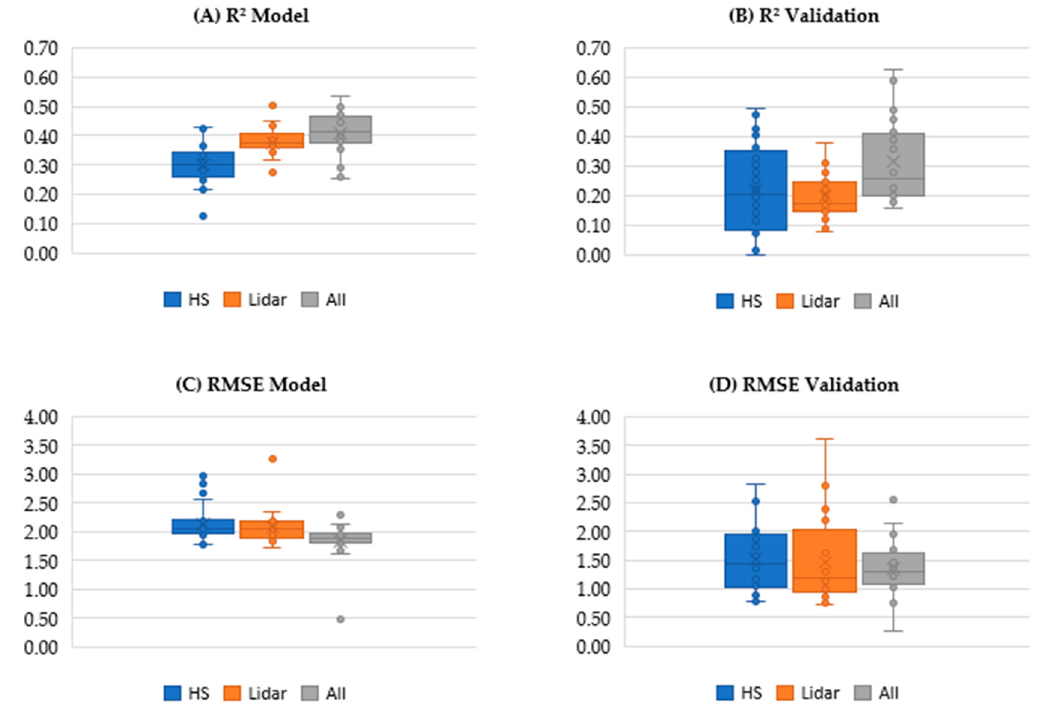
Figure 10. Performance of di ff erent input datasets when employed for modeling forest heights.